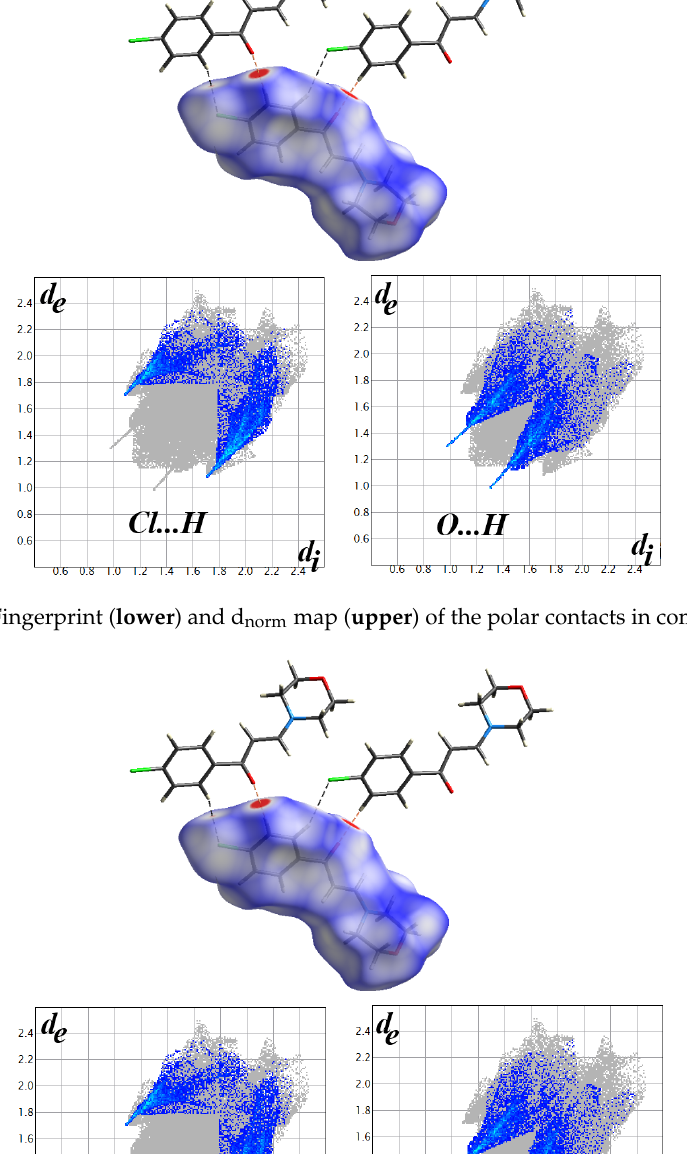
Figure 6. The fingerprint (lower) and d norm map (upper) of the polar contacts in compound 2 .